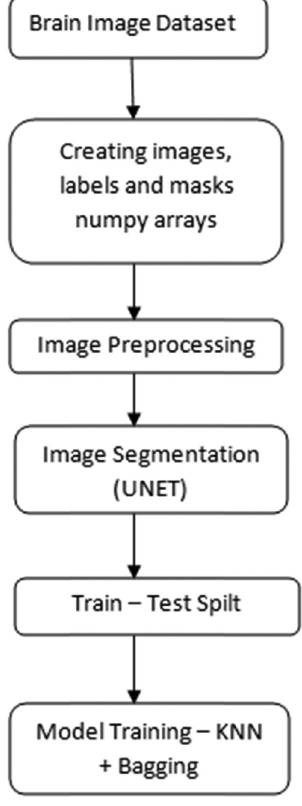
Figure 3: Block diagram for the proposed